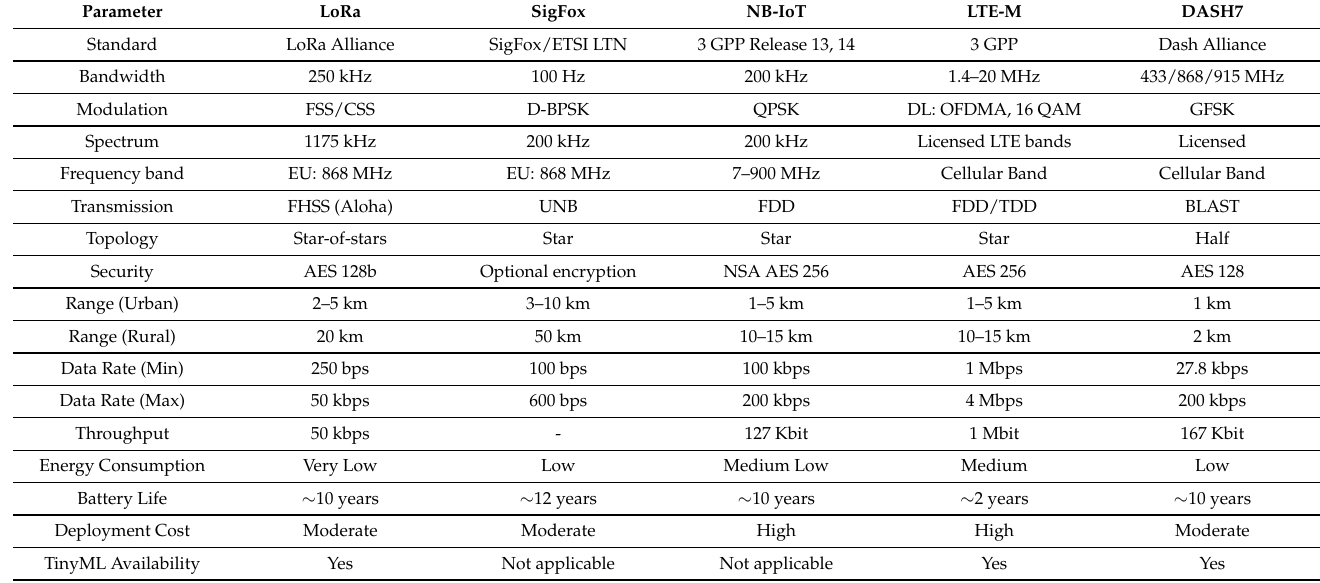
Table 7. Comparison of LPWAN technologies (Compiled from [161–167]).